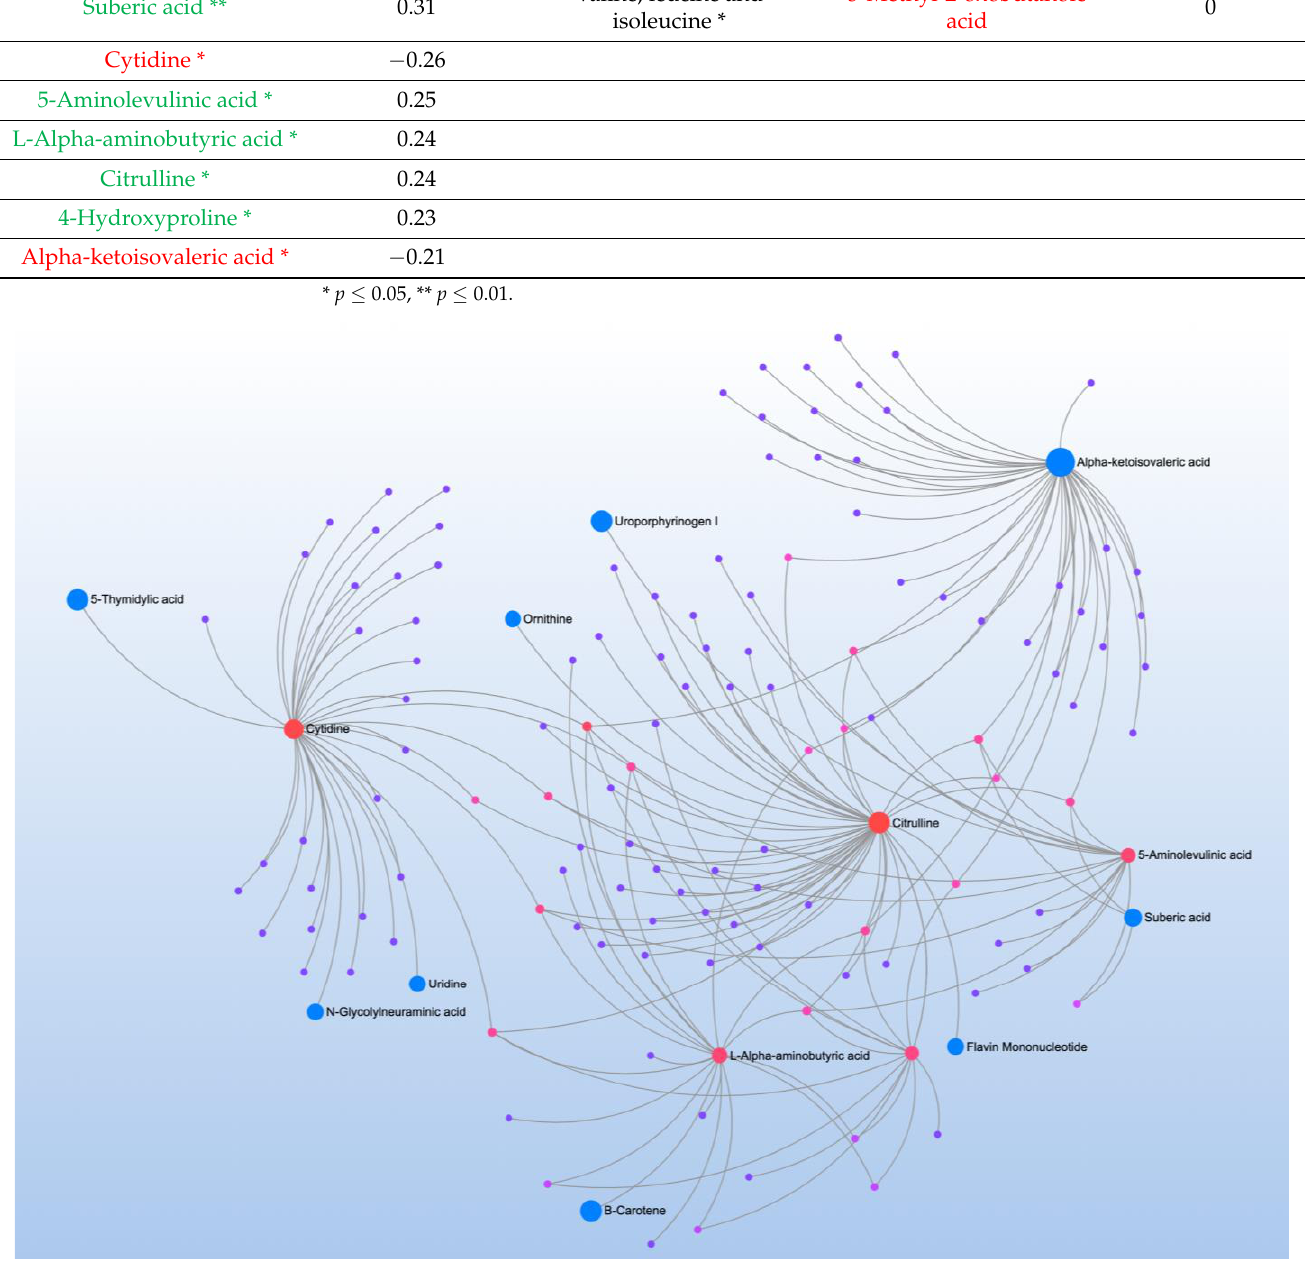
Figure 11. Metabolite-metabolite interaction network for significant metabolites that correlate to in- tracellular reduced glutathione redox ratio. Size of the node indicates importance in the network. The interaction analysis demonstrated various pathways including nucleotide, urea cycle and branched chain amino acid metabolism.